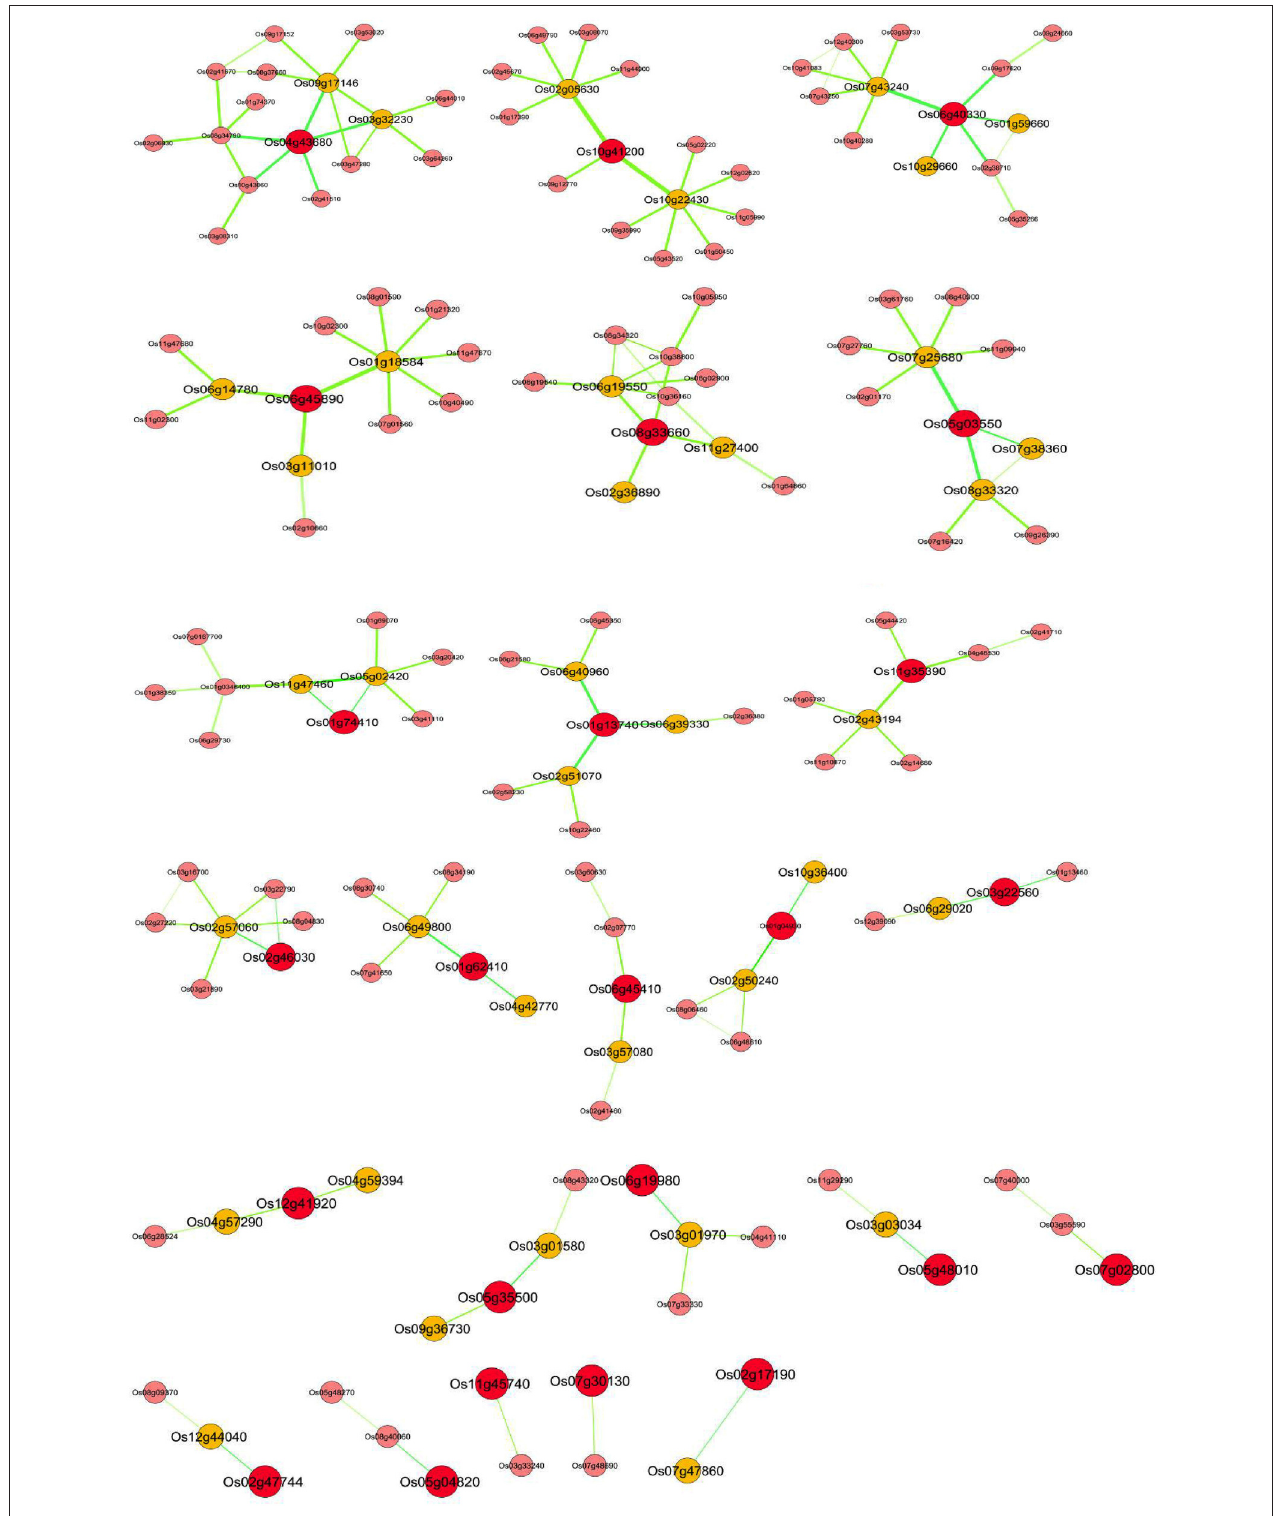
FIGURE 5 | OsMYB transcriptional co-regulatory network constructed using guide-gene approach. The co-expression network of 24 reported drought responsive genes as guide OsMYBs (RAP_ID, enlarged red circle); their putative first neighbor target gene (RAP_ID, orange circle) based on integrative analysis of coexpressed gene and over representation of target promoter motif enrichment with that class of transcription factor. A link between two nodes indicates direct interaction with PCC > 0.64 and MR < 10. The thickness and brightness of the edges represents the confidence of the interaction.